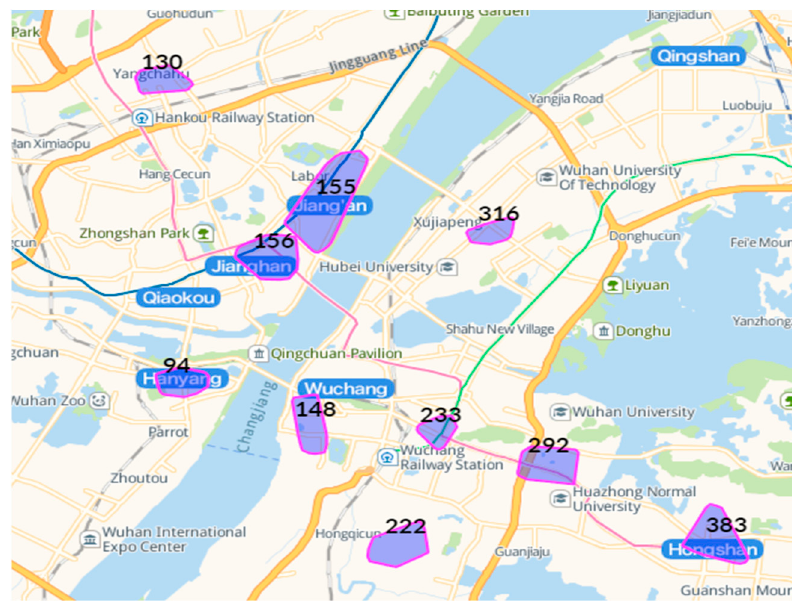
Figure 3. Top 10 intensive functional regions.